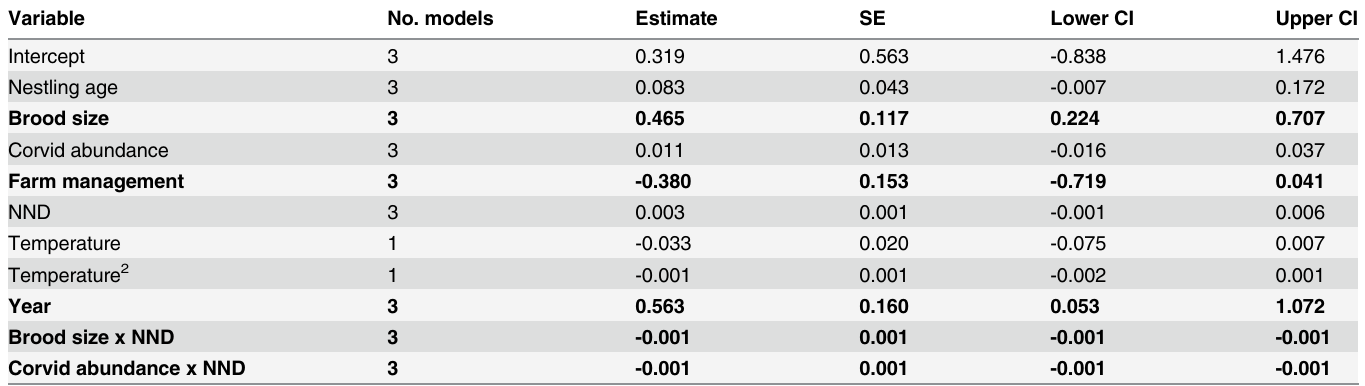
Table 7. Averaged model estimates and 95% confidence intervals from the three top models predicting parental provisioning rate (marginal R 2 = 0.53; conditional R 2 = 0.54).